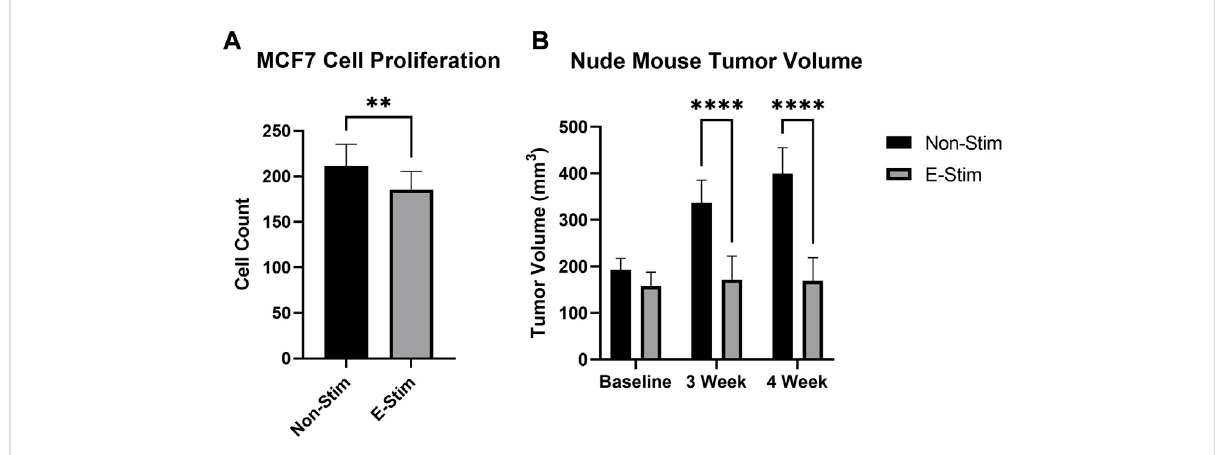
E-Stim perfusate suppresses tumor growth. Treatment with E-Stim perfusate resulted in reductions in both cell counts in vitro (A) and tumor volume in vivo (B) when compared to the Non-Stim condition. ** denotes p < 0.01, **** denotes p <